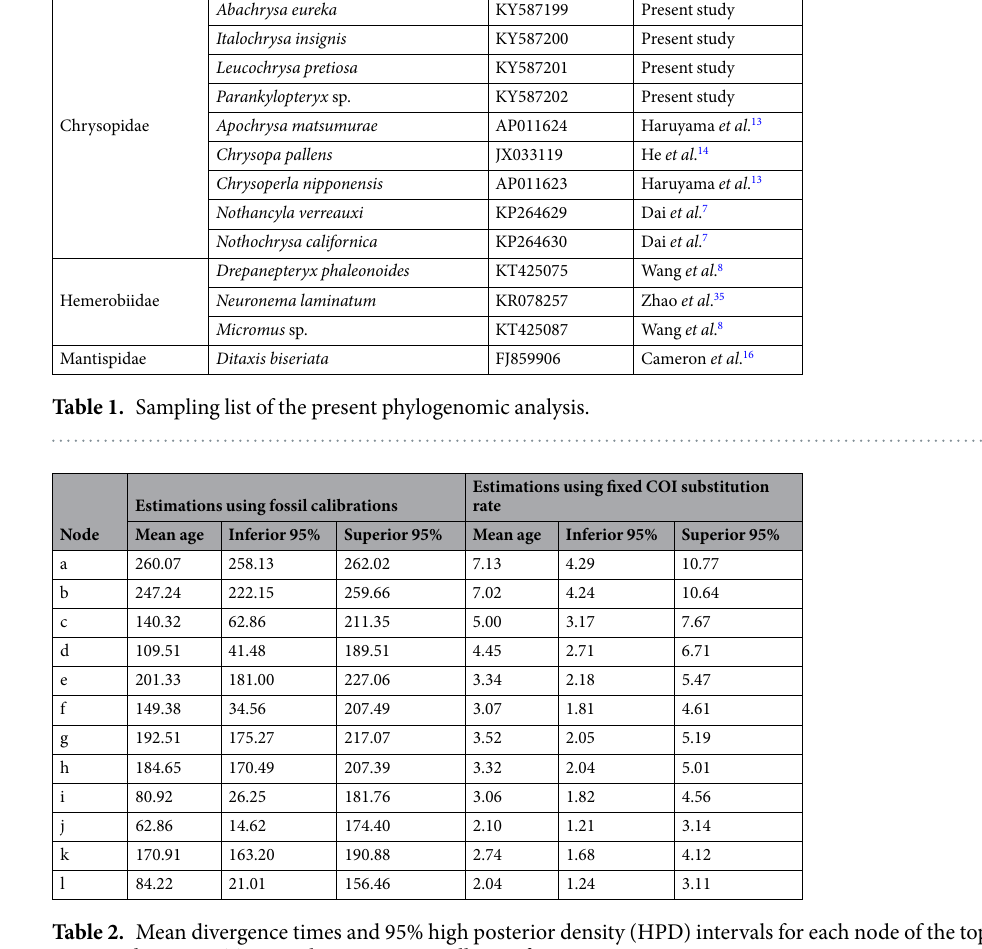
Table 2. Mean divergence times and 95% high posterior density (HPD) intervals for each node of the topology presented in Fig. 4. Time-scale units are in millions of